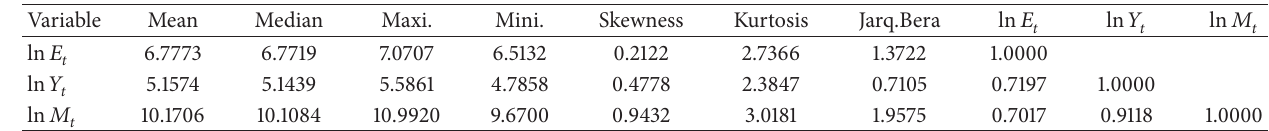
Table 1: Descriptive statistic and correlation matrix.